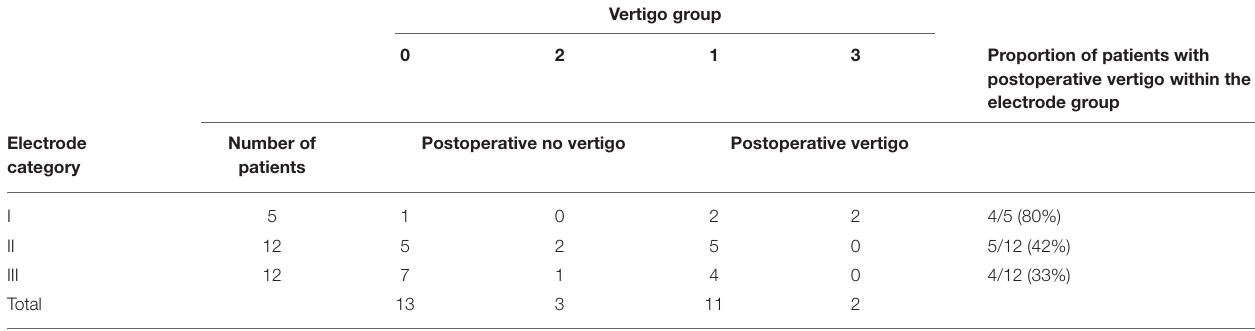
TABLE 9 | Occurrence of vertigo within electrode categories (for information on vertigo group, see Table 2